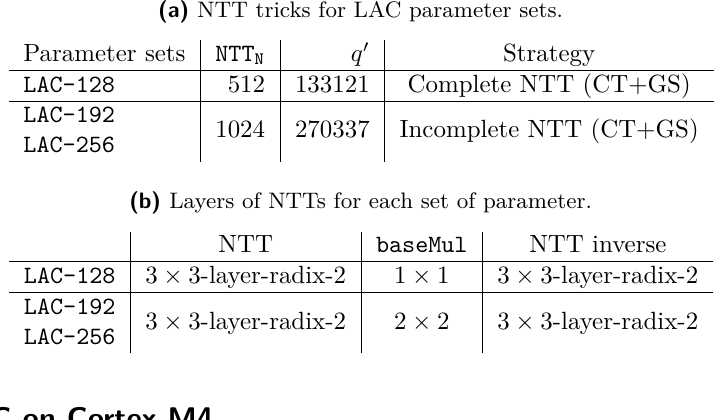
Table 4: Overview of NTTs for LAC on Cortex-M4 (a) NTT tricks for LAC parameter